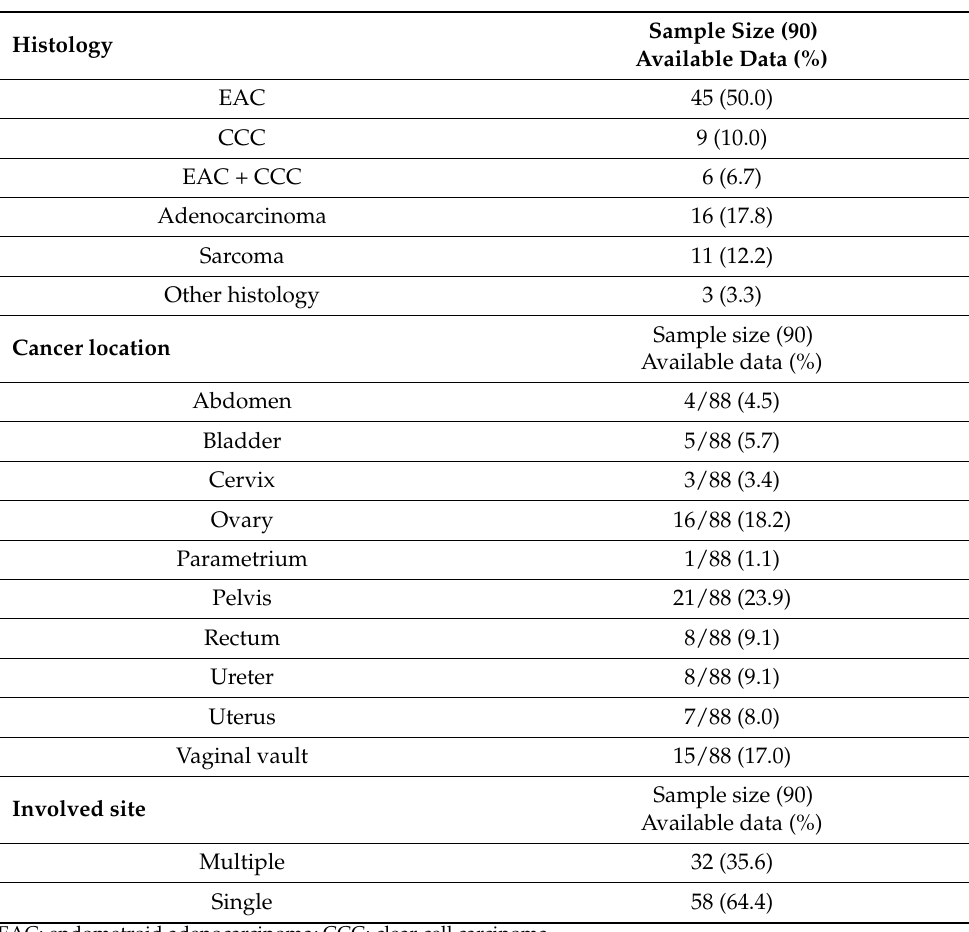
Table 4. Cancer lesion characteristics.